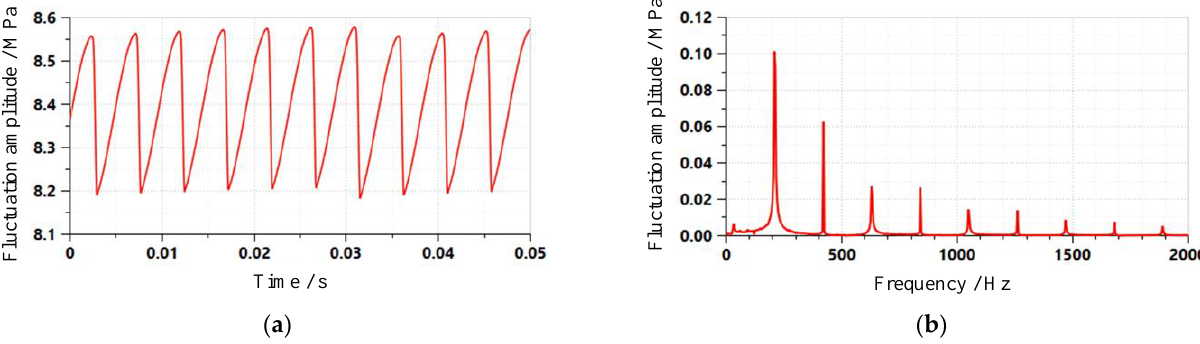
Figure 8. Load pressure ( p 2 = 8.38 MPa) waveform. ( a ) Time domain diagram; ( b ) frequency domain map.